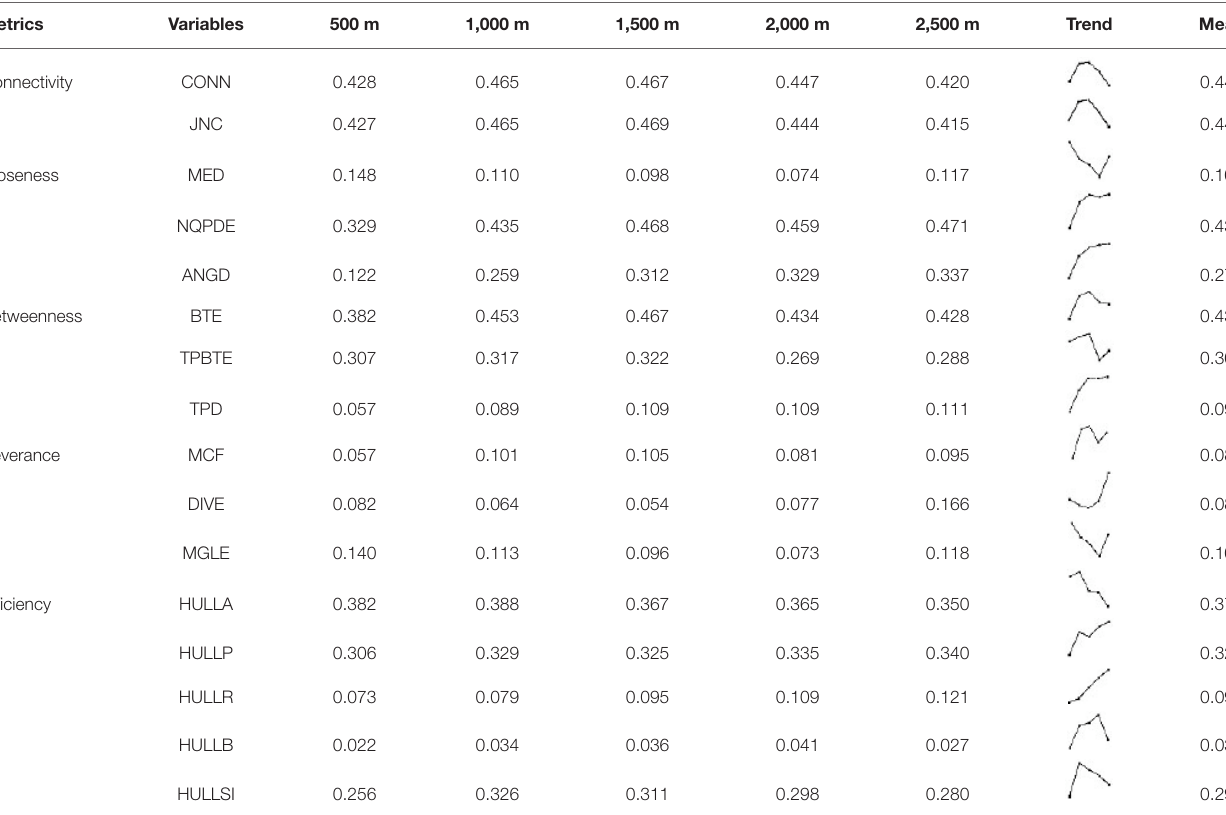
TABLE 3 | q statistics between urban vitality and spatial network metrics at multiple